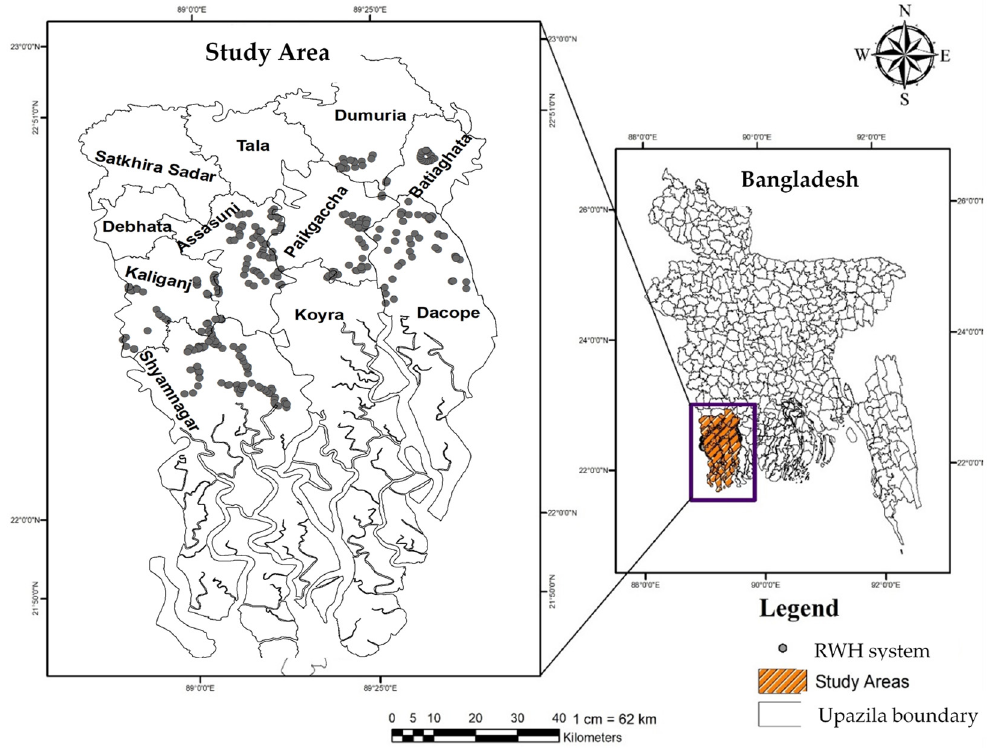
Figure 1. Locations of selected household RWH systems in Khulna and Satkhira district.